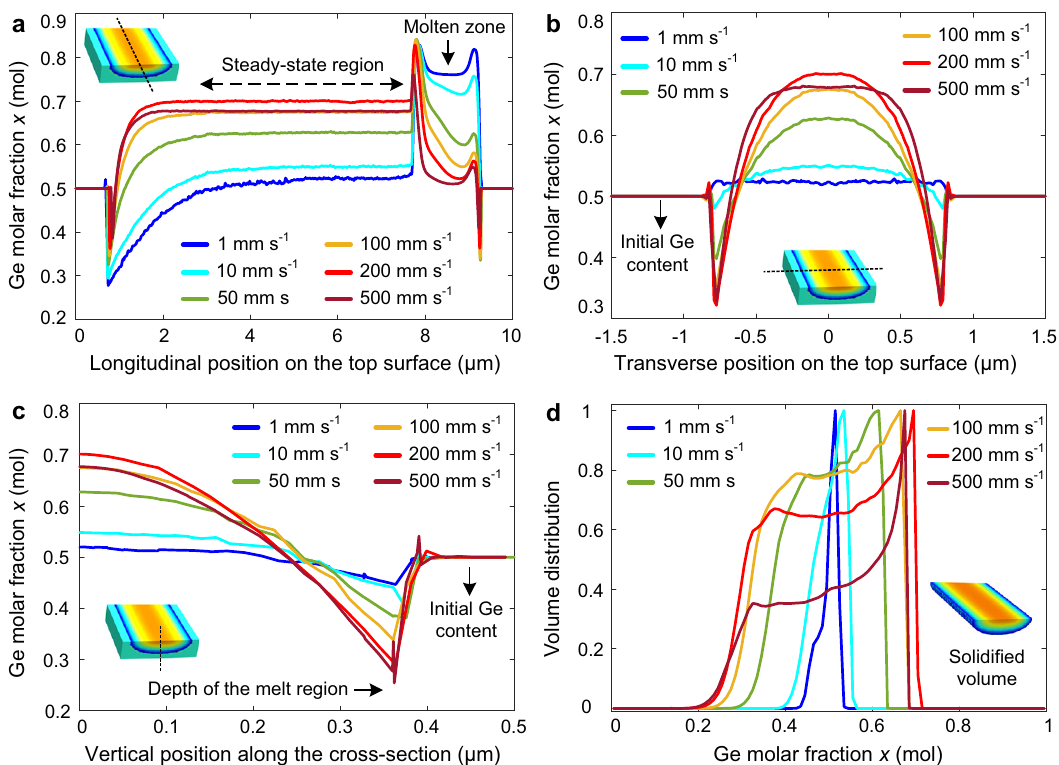
Fig. 3 Simulation results showing the Si 1 − x Ge x composition pro fi les along different directions on various surfaces, and dispersion of the composition for scan speeds in the range of 1 – 500 mm s − 1 . Inset fi gures show the surface and direction (dotted lines) where the composition pro fi le was taken. Ge molar fraction x (r) along the a longitudinal and b transverse directions on the top surface, and c along the vertical direction at the cross-sections of laser- written SiGe microstripes. d Normalized volume histogram showing the scan-speed-dependent dispersion of the initial composition x 0 = 0.5 within the whole solidi fi ed volume in terms of the Ge molar fraction. The bin size for histograms is Δ x = 0.01. Inset fi gure shows the laser-processed volume in the steady-state region, where the histograms were calculated.